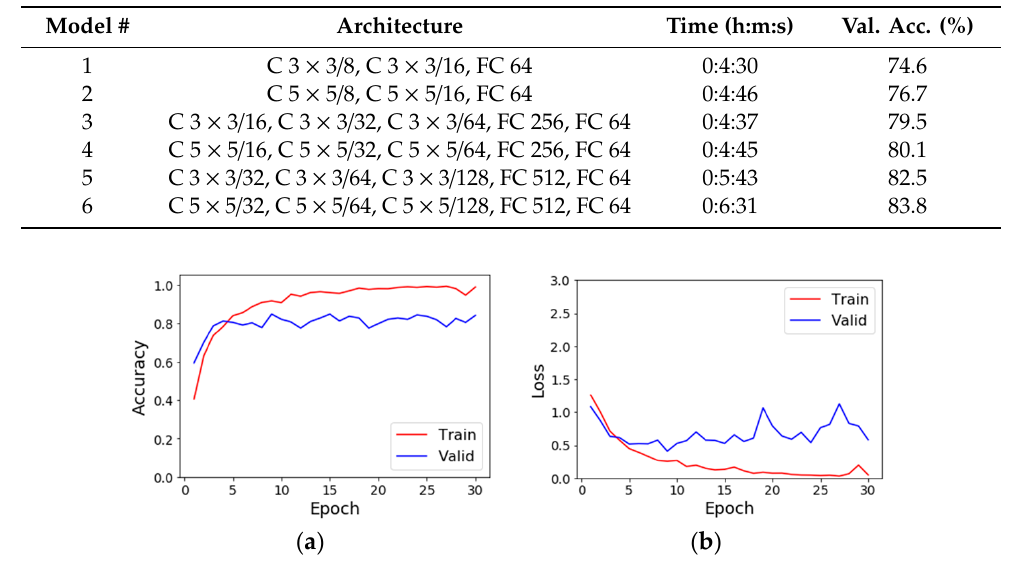
Figure 4. ( a ) The accuracy and ( b ) the loss values of the training and validation dataset for Model 6. Table 3. Experimental results with six architectures. The convolutional layers’ parameters are denoted as “C kernel size/number of kernels”. The fully connected layers are denoted as “FC number of hidden units”. Epoch = 30, learning rate = 1 × 10 − 4 .